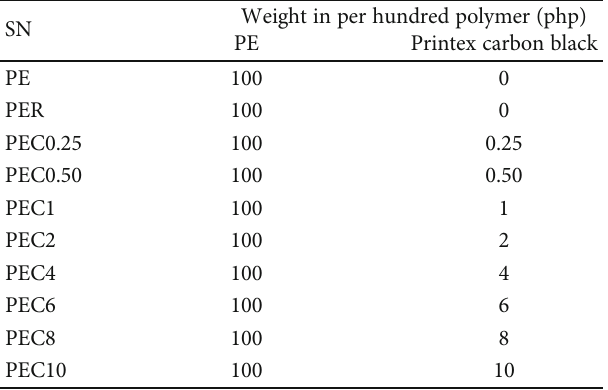
Table 1: Formulations of polyethylene (PE)/Printex carbon black